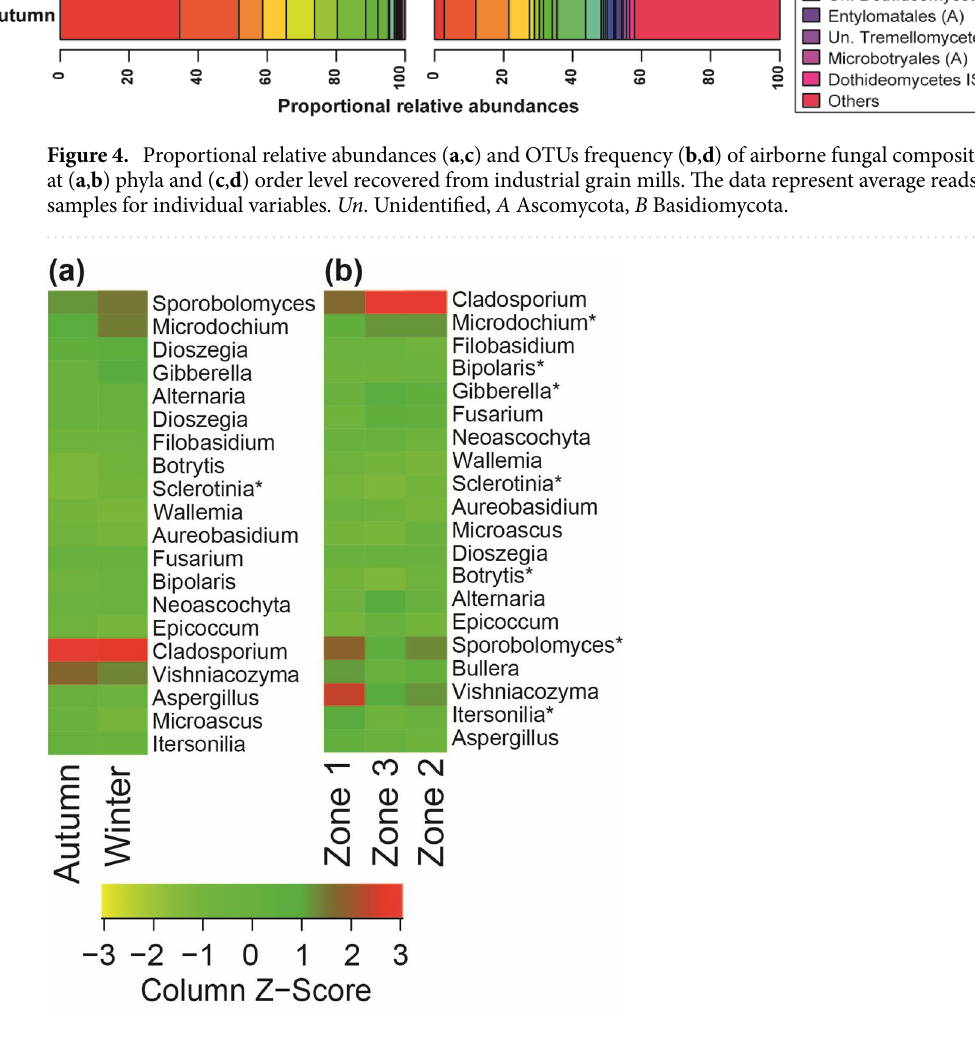
Figure 5. Hierarchical clustering-based heat plots for proportional abundances of different fungal genera that varied significantly between ( a ) seasons (autumn and winter) and ( b ) three different climatic zones in the air of Norwegian industrial grain mills. Genera with statistically significant differences (ANOVA and Tukey’s HSD post-hoc test) among studied factors are shown with